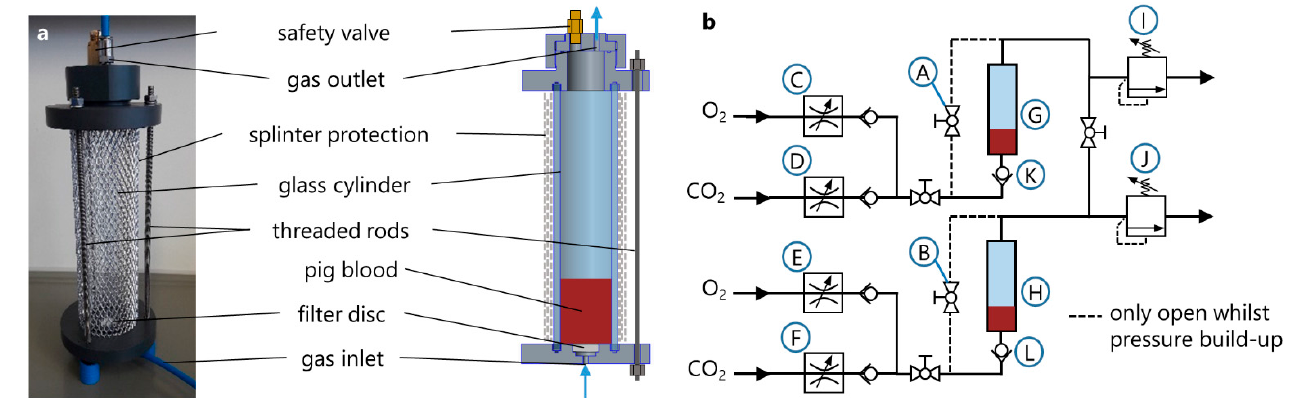
Figure 3. Structure of pressure-resistant BO ( a ) and main experimental setup for the operation of two BOs ( b